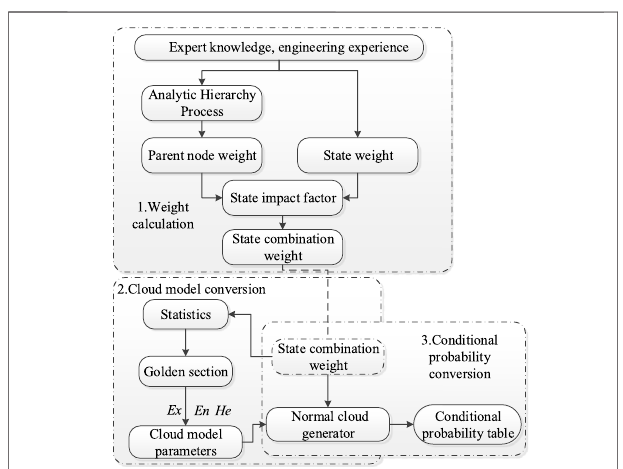
FIGURE 3 | MCPT construction fl